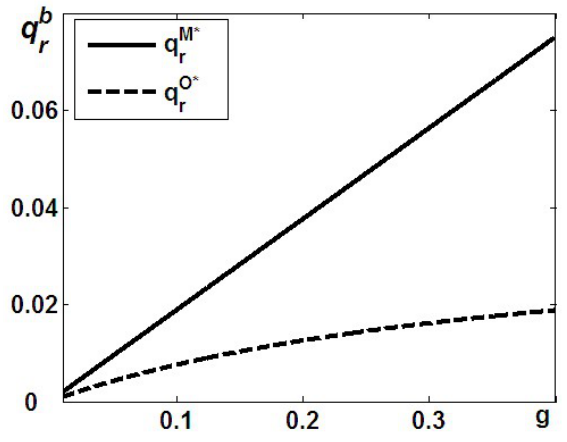
Figure 1. Effect of g on q b r